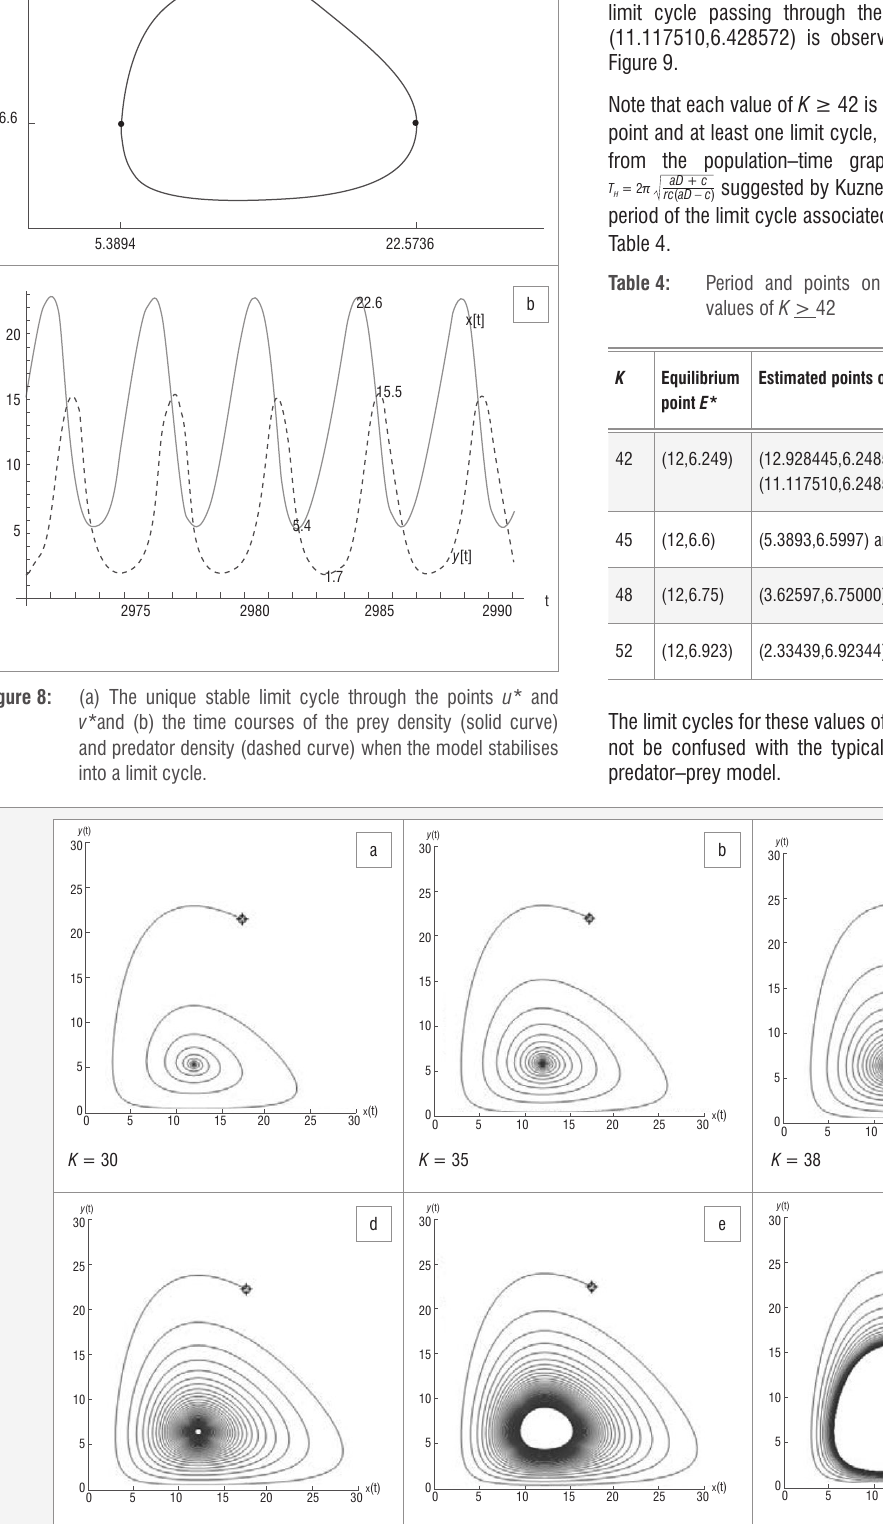
Case 3: K = 42 Using the same approach as before, a Hopf bifurcation is observed because a stable attracting spiral point bifurcates into an unstable equilibrium point as the value of K is increased from K < 42 through